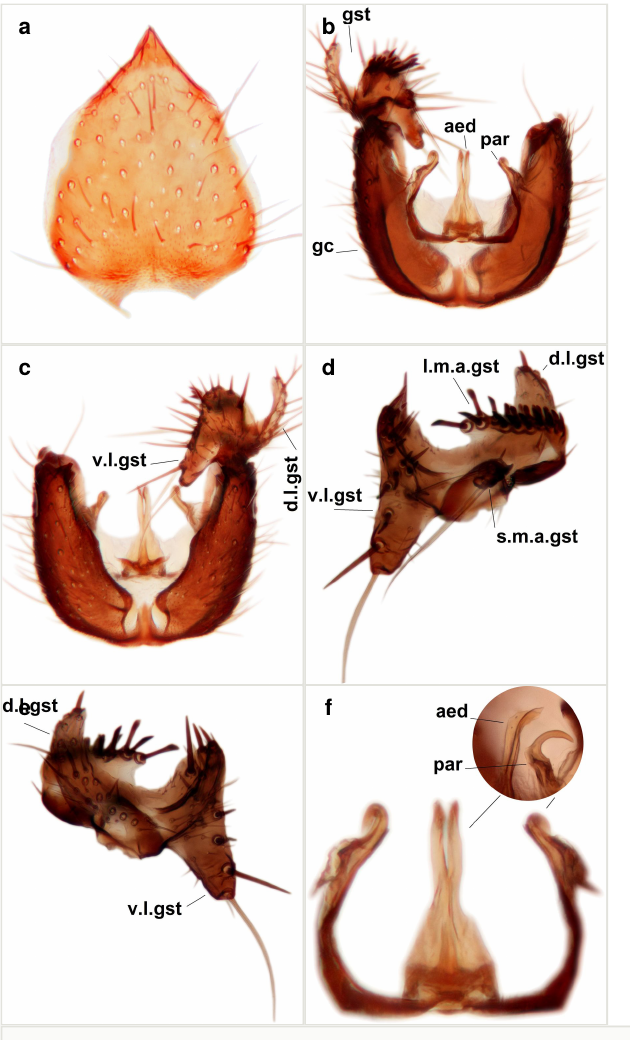
Figure 6. Sciophila curvata Salmela sp.n., holotype male,